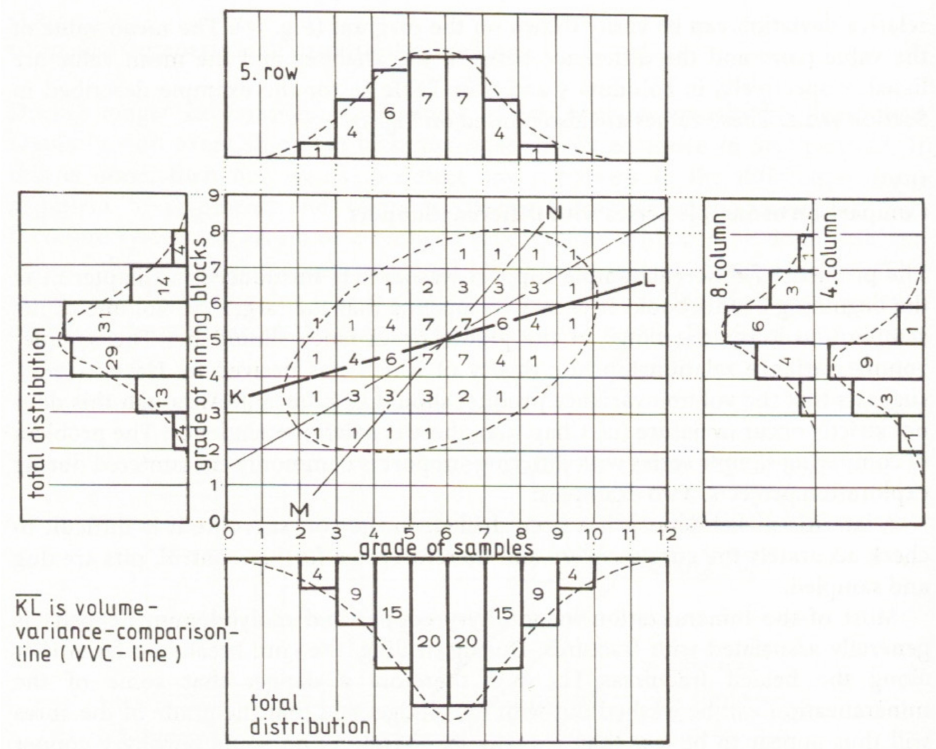
Figure 9. The classical Krige diagram comparing mining blocks and samples from South African gold mining, illustrating the correlation between grades of samples with grades of corresponding mining blocks [24], with permission of the author, 1995; for use by Wellmer, 1996